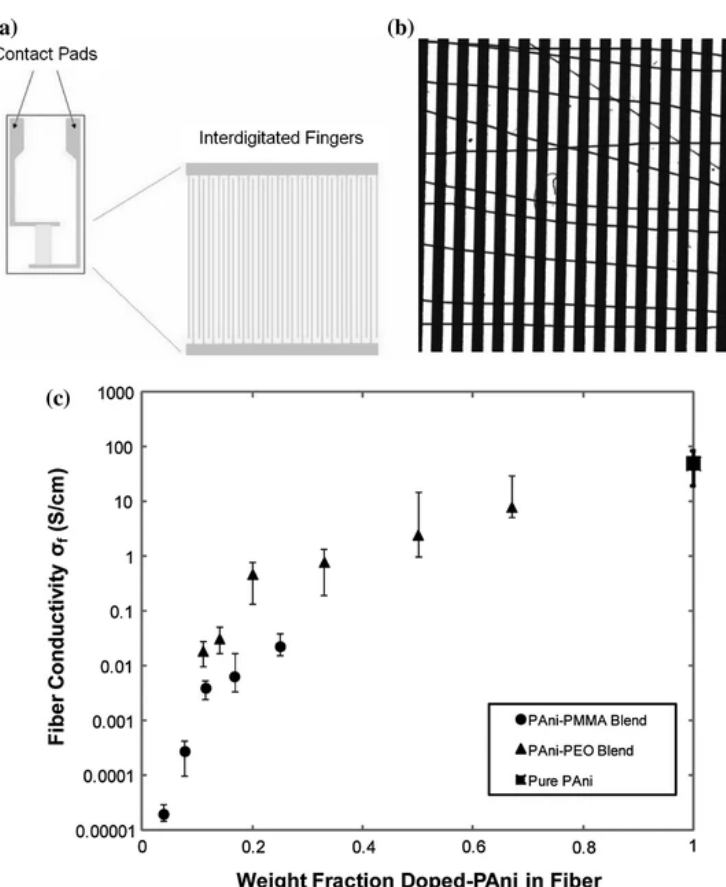
Figure 23. Contact resistance calculation by utilizing overall fiber resistance on interdigitated elec- trodes ( a , b ). Fiber conductivities dependence on weight fraction of doped polyaniline in fibers ( c ). Reproduced from [159] with permission of the American Chemical Society.